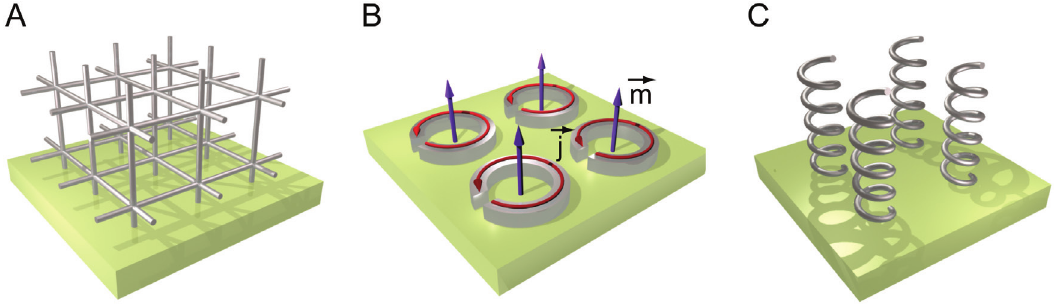
Figure 1 Schematics of some representative metamaterials. (A) Metallic wires to achieve low-frequency plasmons by reducing the electron density and increasing the effective electron mass. (B) Metallic SRRs to produce artificial magnetism. Around the resonance frequency, (cid:31) there is a strong current ( ) j circulating along the resonator, resulting in an effective magnetic moment ( ). m of metallic helices.